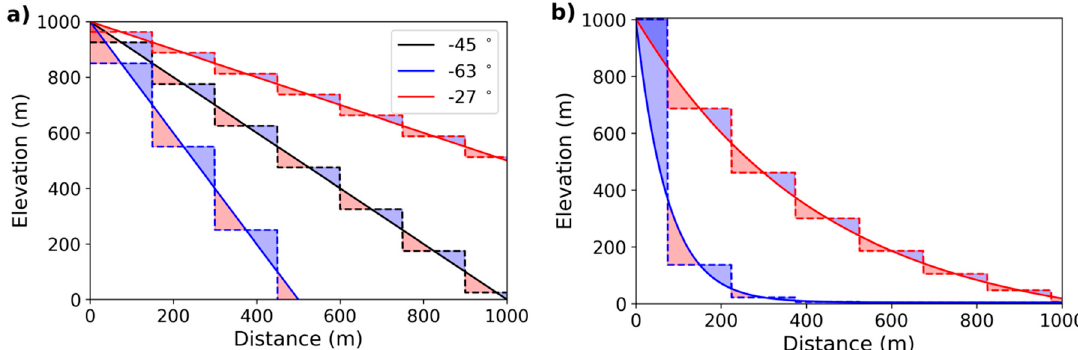
Figure 14. Area errors produced by pixel representation (dashed lines) of actual terrain elevation (continuous lines) for steady ( a ) and curved ( b ) slopes. Blue and red areas represent area gains and losses, respectively.